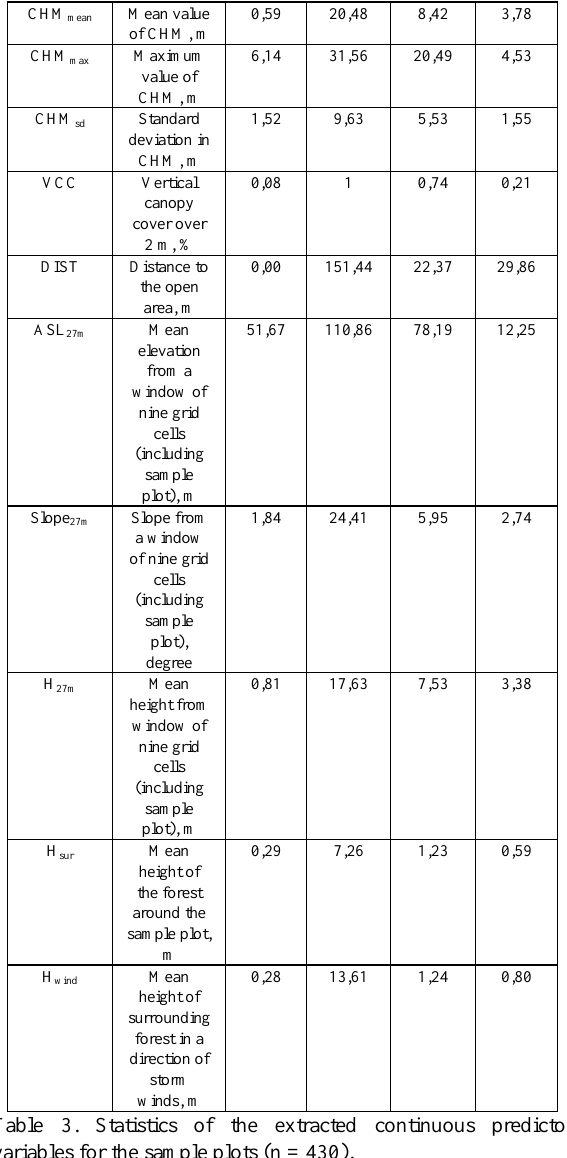
Table 3. Statistics of the extracted continuous predictor variables for the sample plots (n = 430).